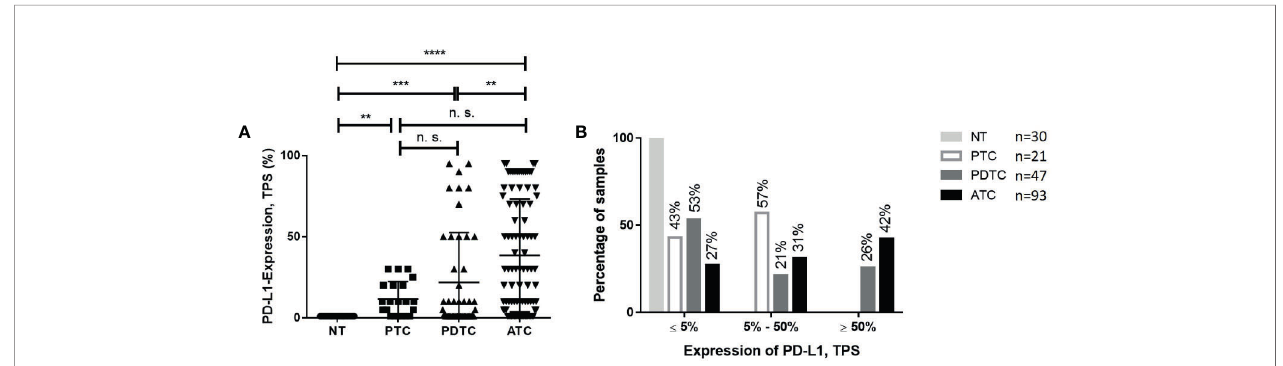
FIGURE 2 | Comparison of PD-L1 expression in ATC or PDTC and PTC or NT. (A) PD-L1 expression as assessed by TPS was signi fi cantly higher in ATC compared to PDTC and tumor specimens compared to normal thyroid (NT). No signi fi cant differences (n. s. = not signi fi cant) could be observed in ATC and PTC and PDTC and PTC. (B) Proportion of PD-L1 TPS categories in PDTC and ATC. 42% of ATC and 26% of PDTC specimen show PD-L1 TPS ≥ 50%. **p < 0.01, ***p < 0.001, ****p <